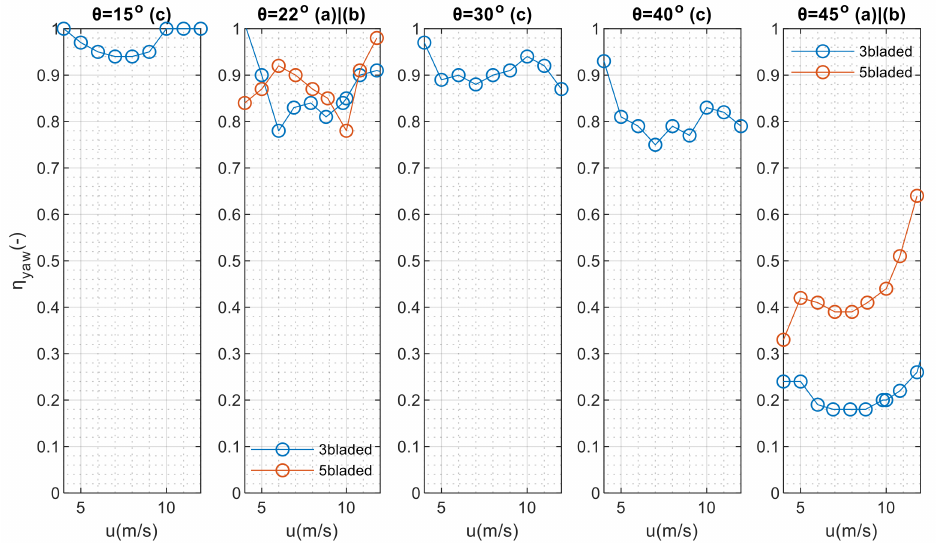
Figure 8. Ratio of experimentally measured power to the reference power at θ = 0 ◦ expressed as η yaw ( − ) at different skew angles θ (15 ◦ , 22 ◦ , 30 ◦ , 40 ◦ , 45 ◦ ) for ( a ) 5 bladed upwind, ( b ) 3 bladed downwind, and ( c ) 3 bladed downwind